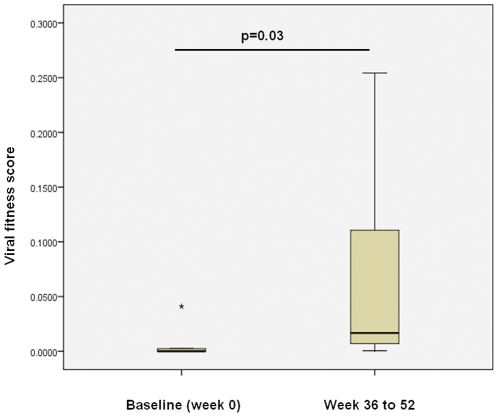
Increasing viral fitness over time observed following analysis of paired isolates obtained from early chronic HIV-1 infection subjects, measured using QPCR.Relative viral fitness scores were calculated for isolates obtained from PHAEDRA subjects and represented on a box-plot. Only subjects from whom a Baseline isolate and at least one additional isolate (Week 36 to 52) were obtained were included in the analysis (n = 8). Shown are viral fitness scores calculated at the final time-point tested (110 h) ex vivo for paired isolates obtained from 8 PHAEDRA subjects. The box represents the middle 50% of values for the data set, the solid line indicates the median value. The vertical ‘whiskers’ extending from the box respectively indicate the lowest and highest observed values. The asterisk represents an extreme outlier. The significance of the observed changes in viral fitness over time is shown (p = 0.03), calculated using a signed rank test.